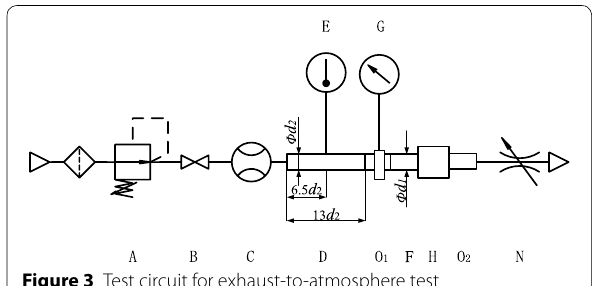
Figure 3 Test circuit for exhaust-to-atmosphere test